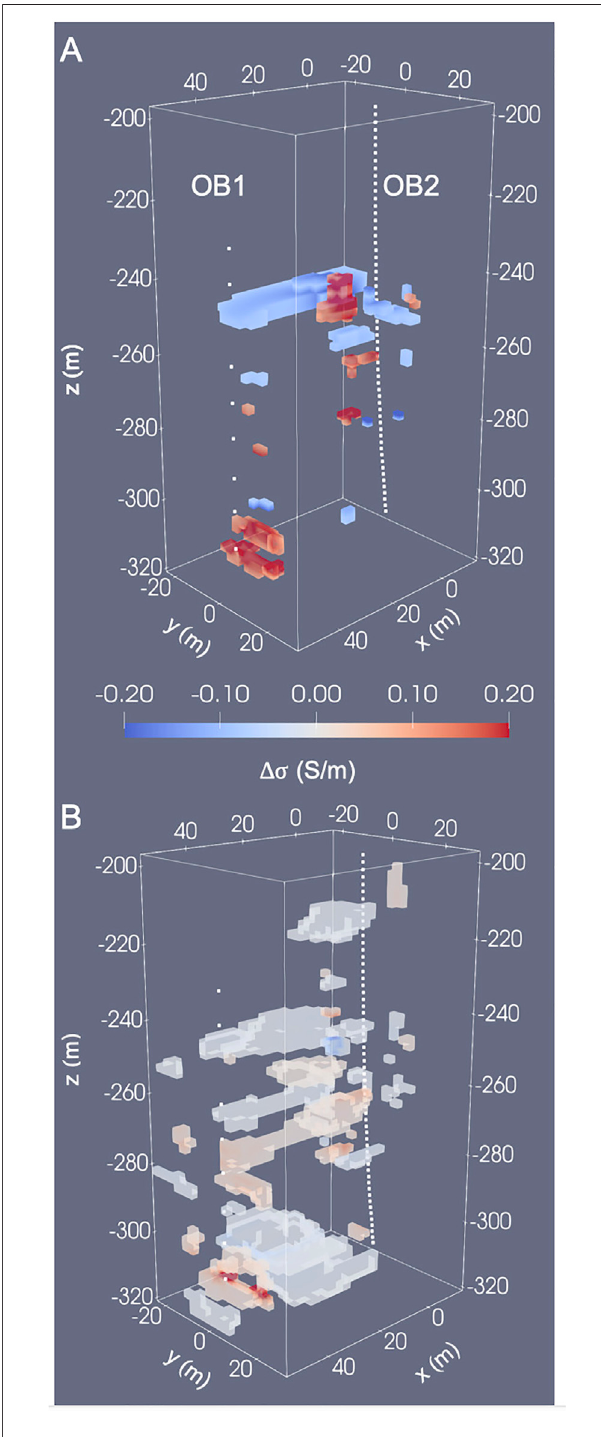
FIGURE 11 | (A) : Total RMS fi tting error for CaMI.FRS fi eld data inversion. (B) : Data (symbols) and fi ts for inversions with constant bounds (blue lines) and variable bounds (purple lines). Real and imaginary vertical- magnetic fi eldsareconvertedintoamplitudeandphase.Theexempli fi ed fi ts correspond to one transmitter-receiver traverse with the source located at z = 270 m (marked by red symbol).